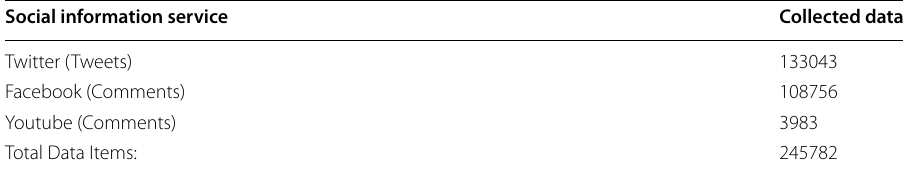
Table 1 Summary of